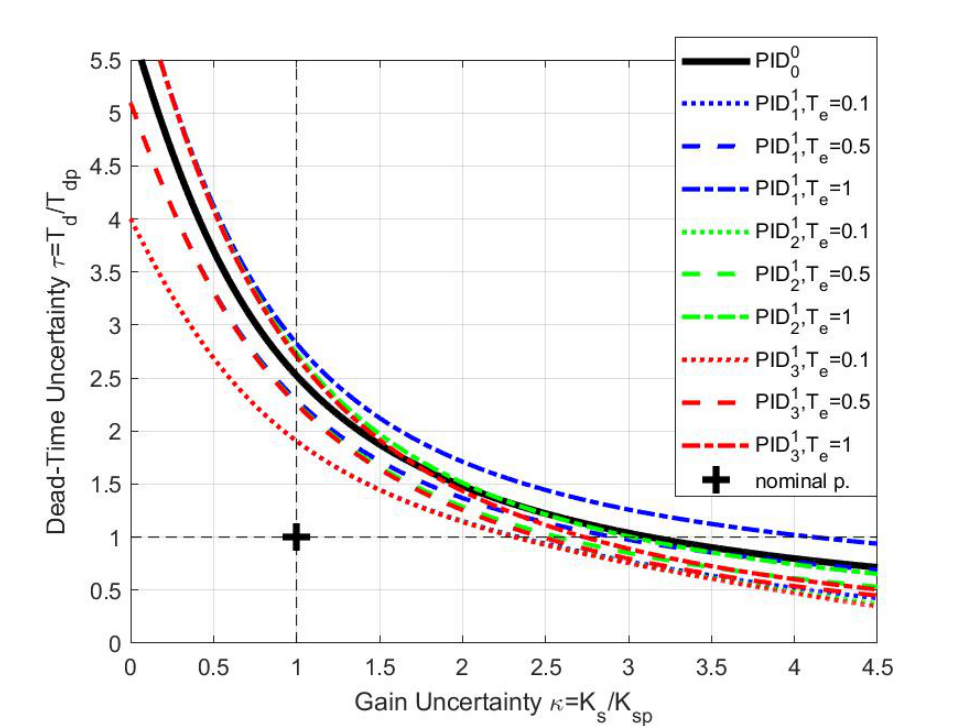
) and filtered PID 1 , PID 1 , and PID 1 control 2 3 0 1